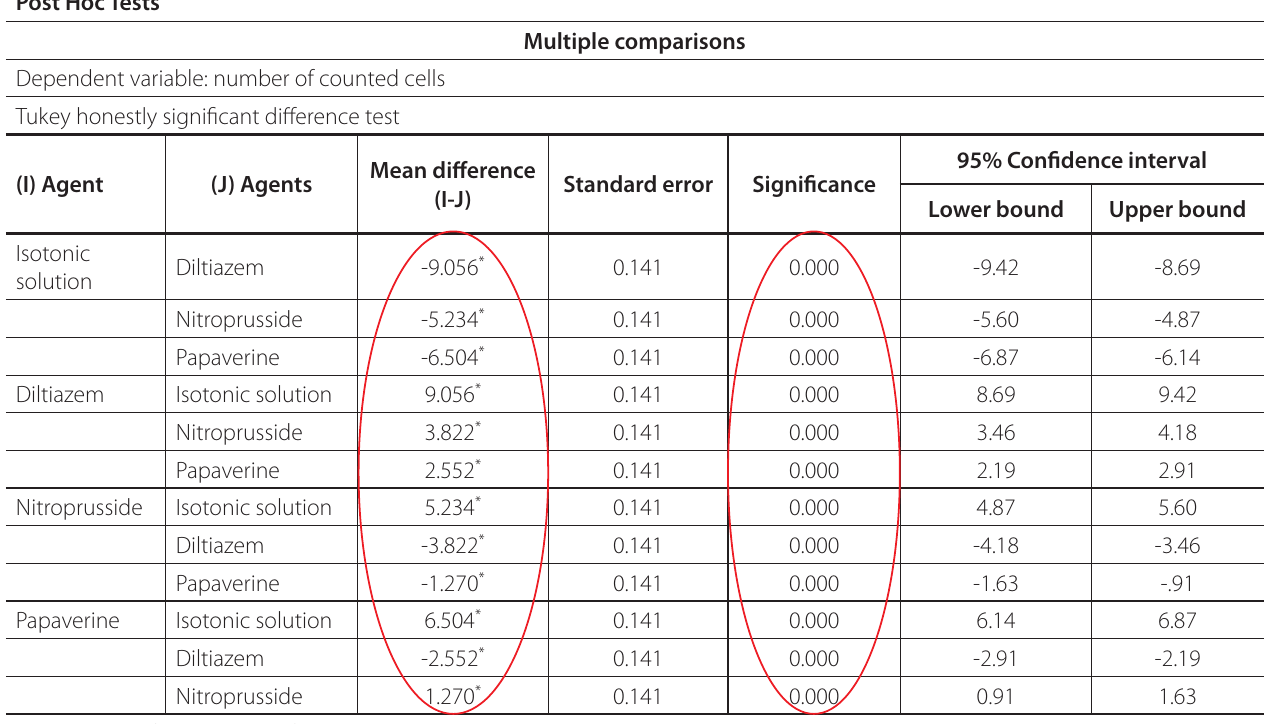
Table 2 . Comparison between the groups with post hoc and Tukey’s tests.